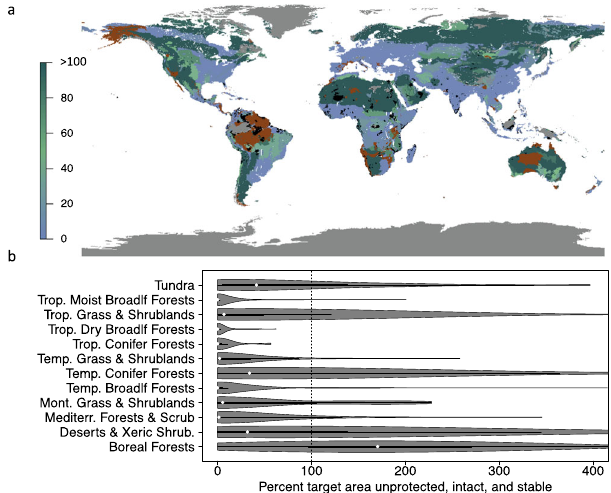
Fig. 5 Opportunity for expanding the protected area estate. For each ecoregion, the area needed to achieve a 30% area-based protection target (after accounting for existing PAs) was compared against the remaining area within the ecoregion that is currently unprotected, intact (low human modi fi cation), and projected to remain climatically stable. A value of 100% means that the remaining unprotected, intact, and stable area is equal to the area needed to achieve the 30% target. Values below 100% imply that the target area exceeds the area that meets these criteria whereas values above imply more area is available than the target. An ecoregion level map of ‘ opportunity ’ for expanding the PA estate is presented in a and summarized by biome in b . Ecoregions in brown currently meet the 30% protection target. Areas in black represent no-analog conditions.